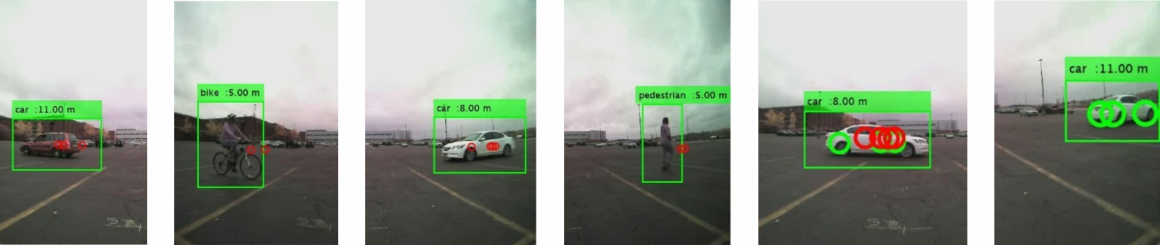
Figure 14. Example images of object detection results.